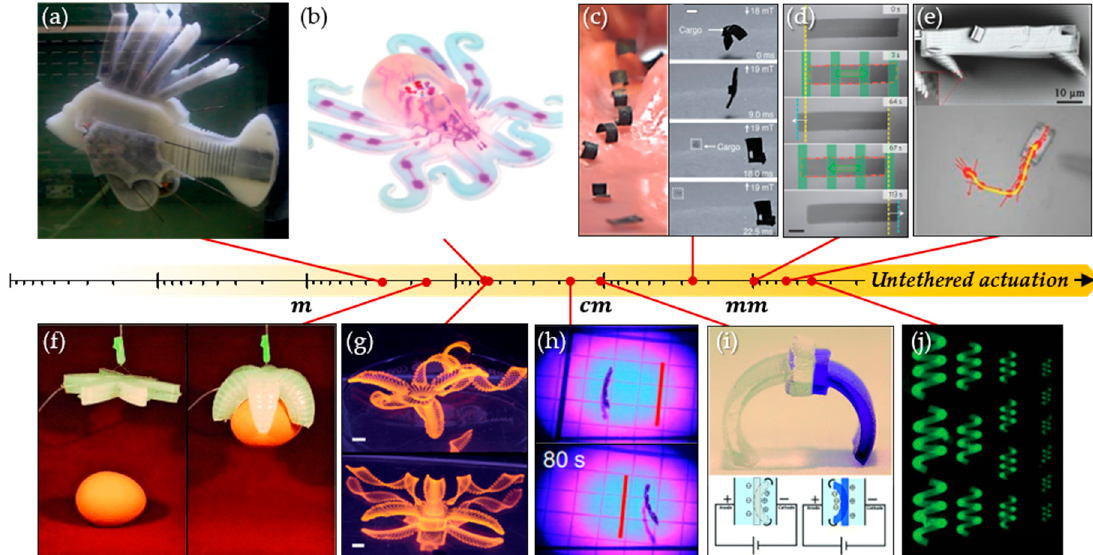
Figure 1. Soft robots (from meter to sub-mm). ( a ) Vascular-system-adapted swimming soft robot. ( b ) Chemical-reaction-fueled pneumatic octobot. ( c ) Multi-modal magnetic soft robot. ( d ) Underwater swimmer with a photoactive liquid crystal polymer. ( e ) Walking liquid crystal polymeric soft robot. ( f ) Pneumatic gripper. ( g ) Biomimetic three-dimensional (3D)-printed hydrogel flower. ( h ) Helical photomobile liquid crystal polymeric soft robot. ( i ) Electro-active walking soft robot. ( j ) Magnetic